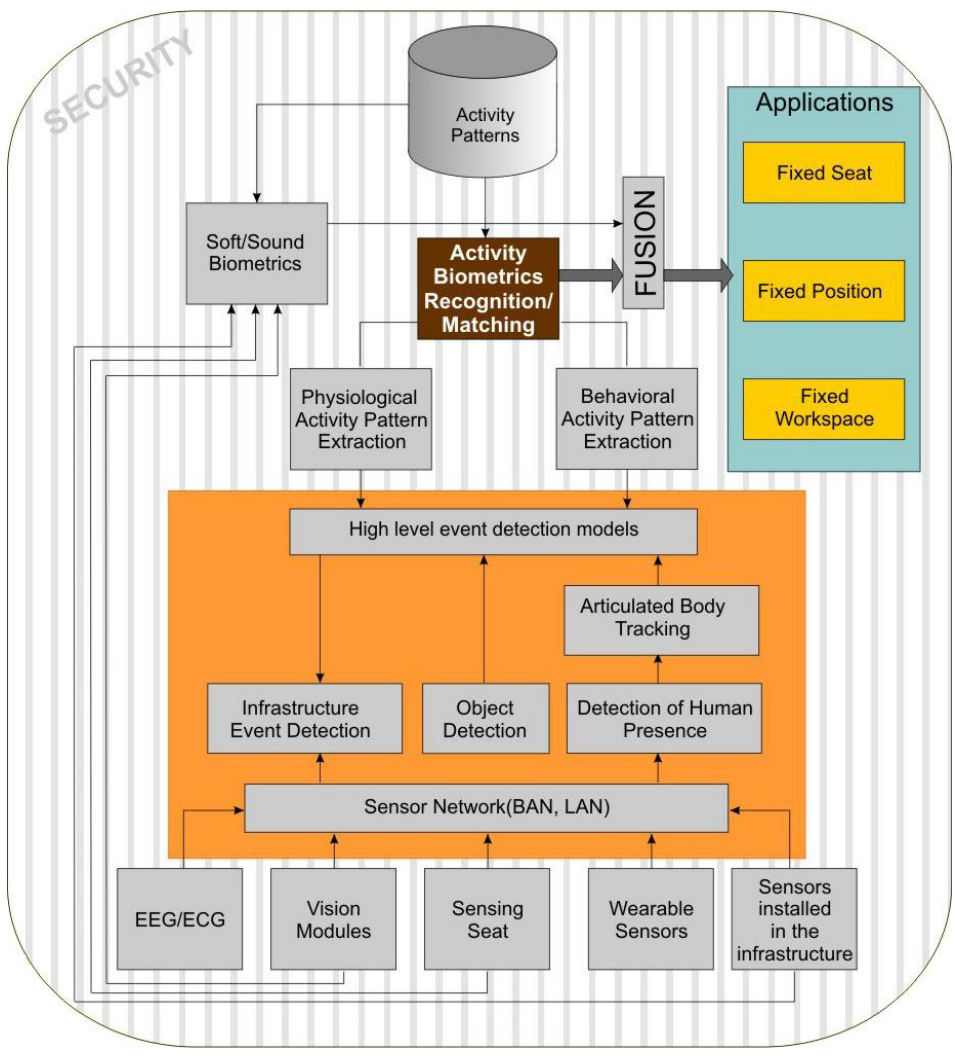
FIGURE 1. The ACTIBIO